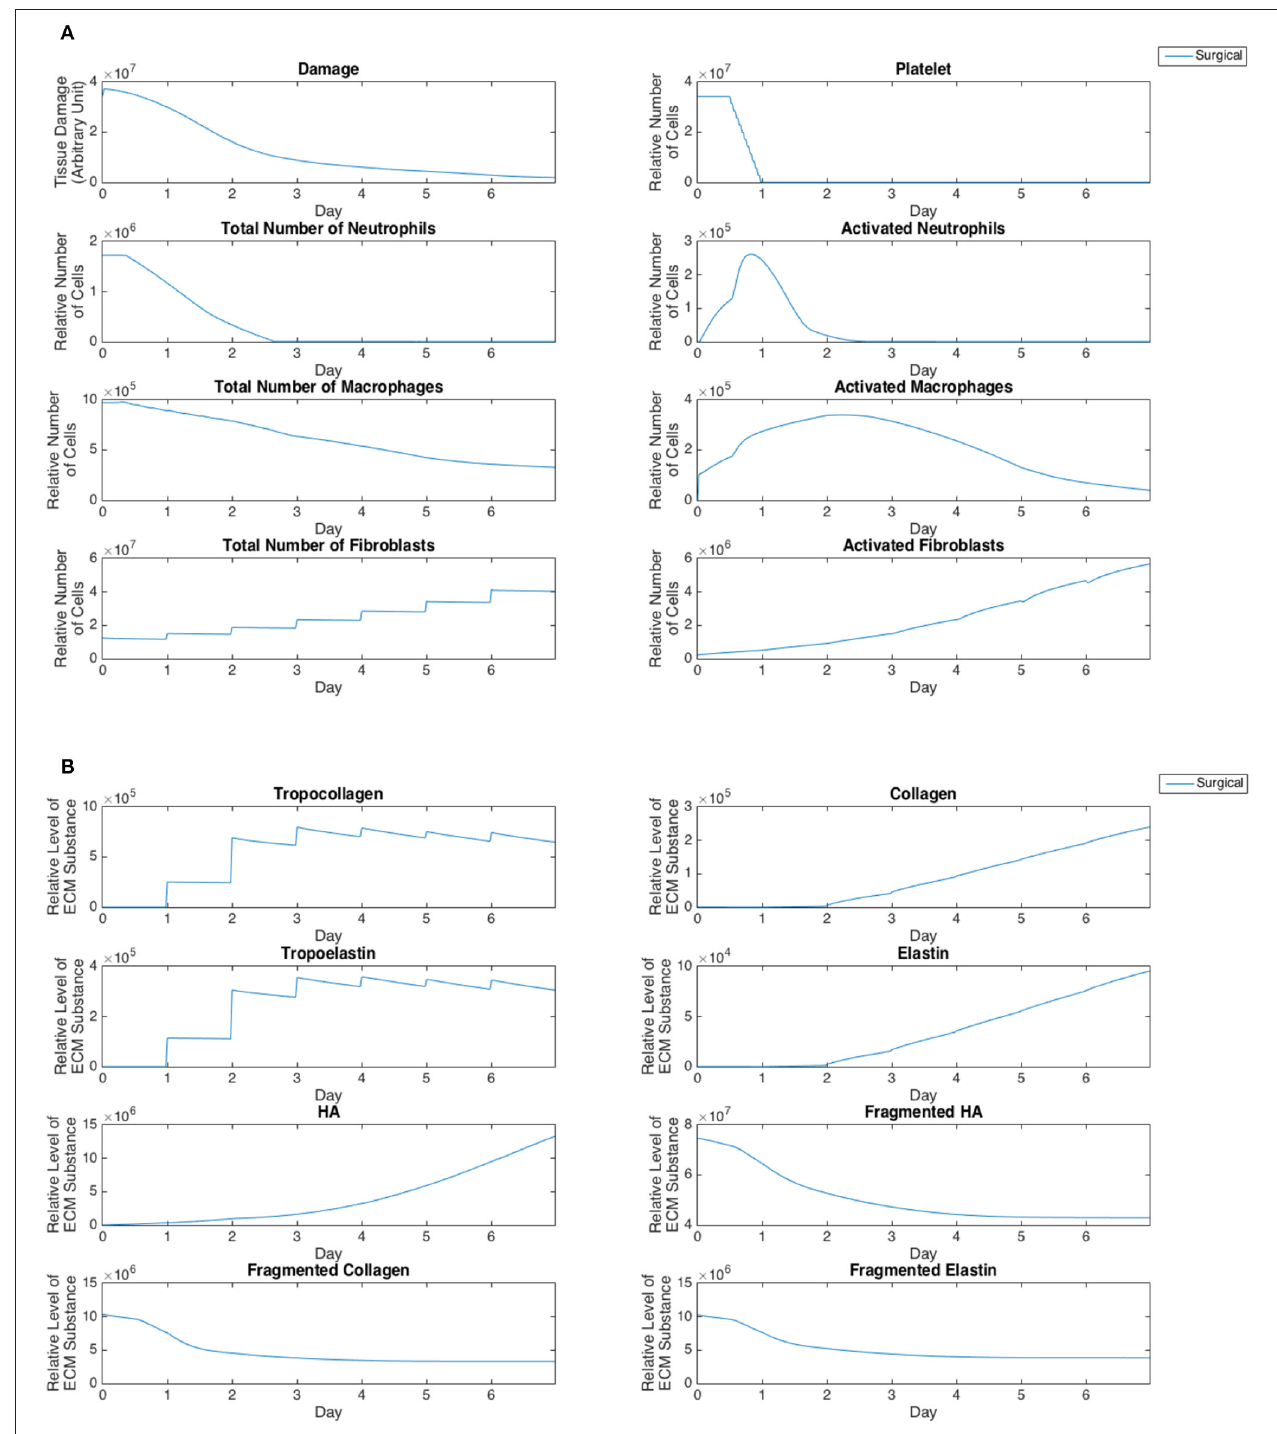
FIGURE 8 | Simulation outputs. (A) Tissue damage and cell populations. (B) ECM subtances.